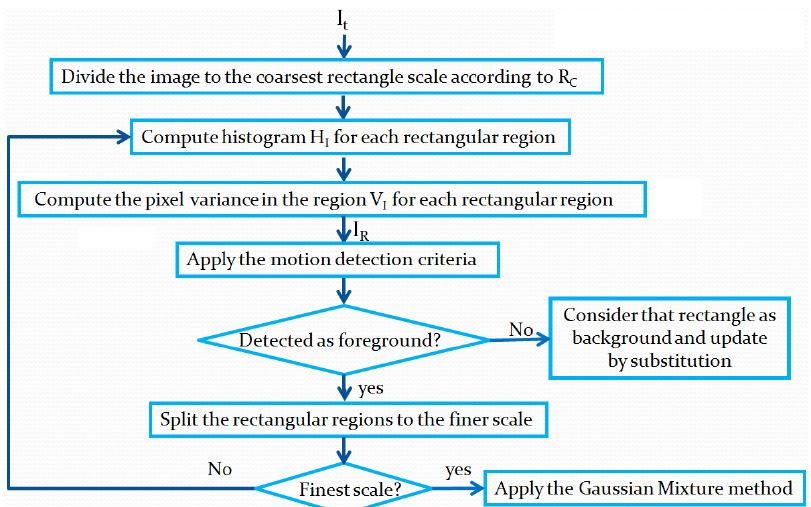
Figure 3. Steps in background updating and motion